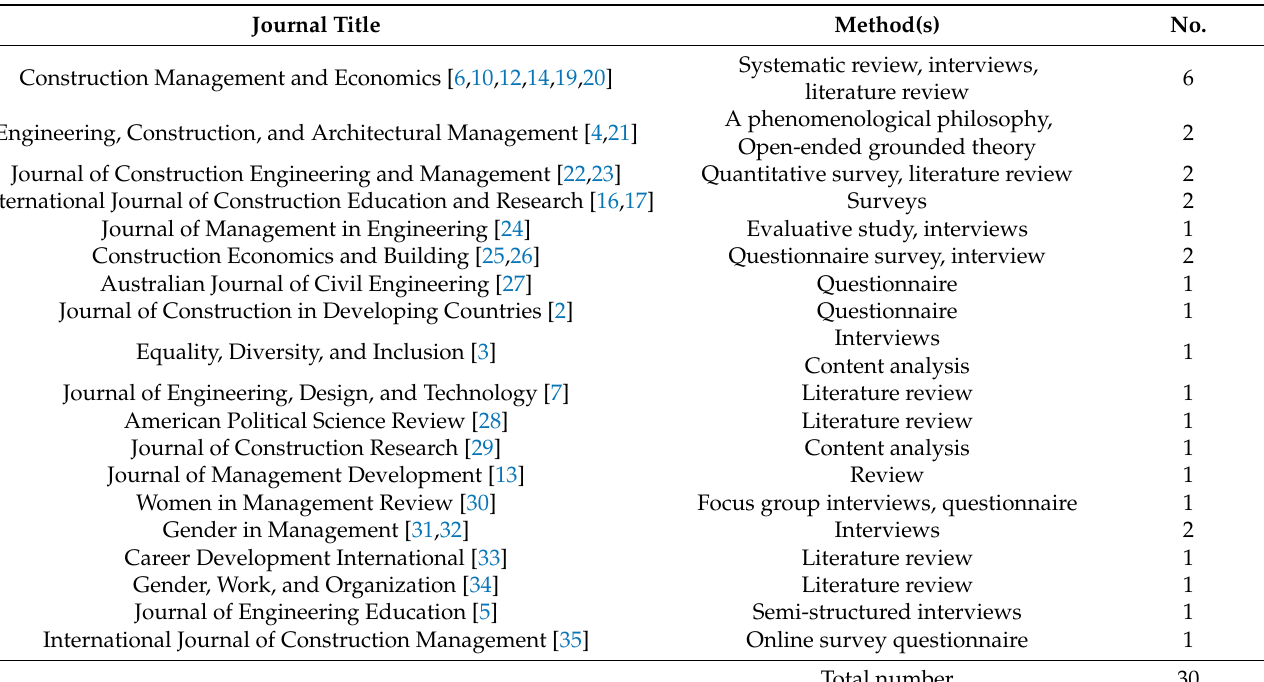
Table 5. Article journals and methods of research.